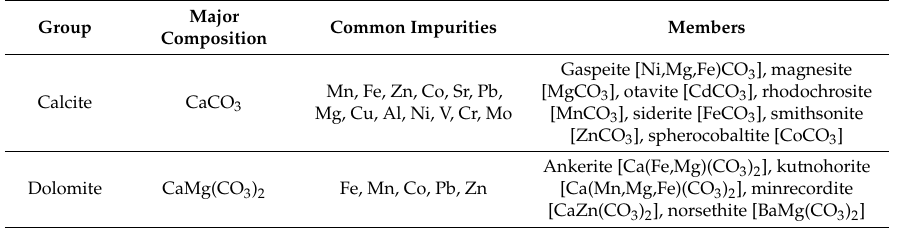
Table 4. Major mineral groups and their associated members generally found in carbonate rocks